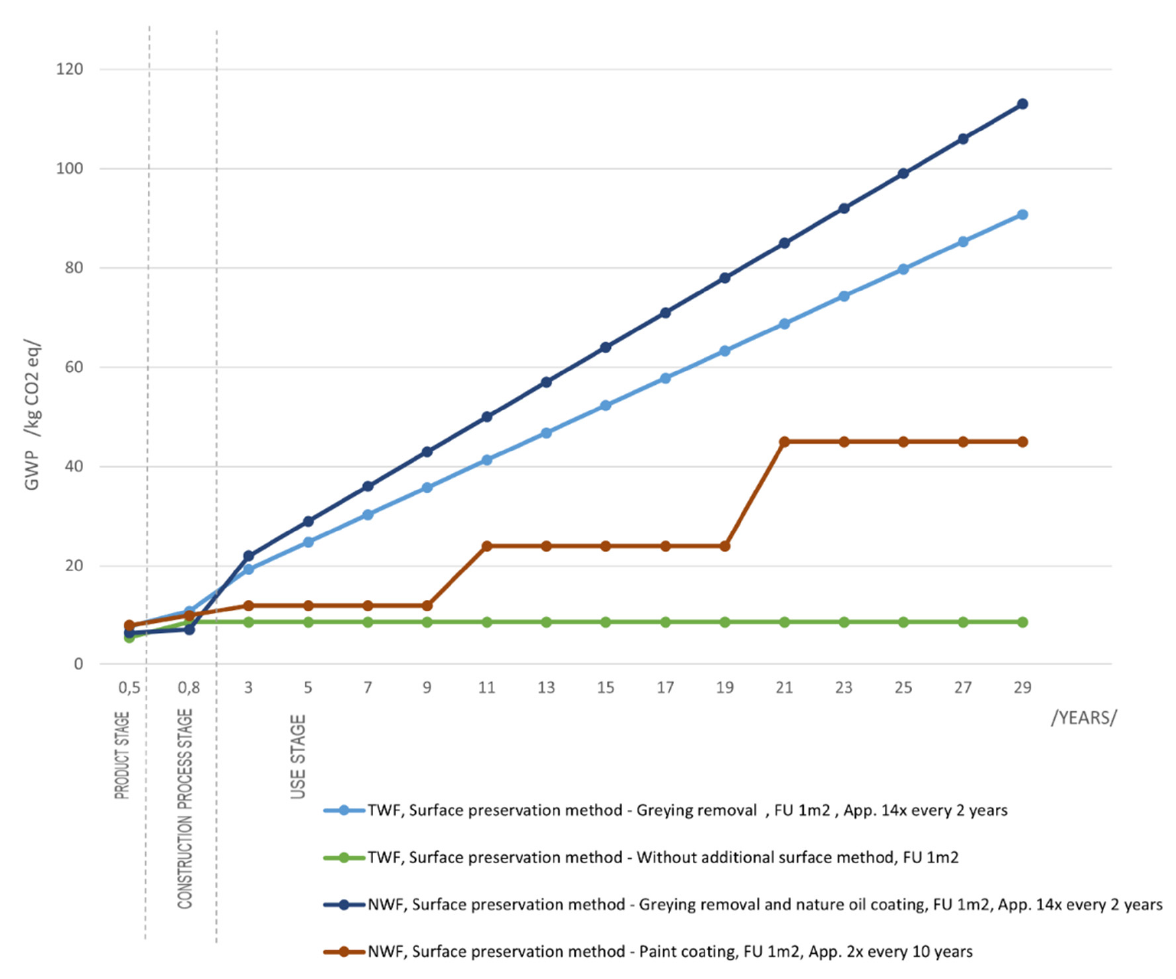
Figure 8. GWP parameter for a 30-year horizon determined by the EPD method, where maintenance-free service life of the thermally modified wood façade is declared by the manufacturer of (2018) V1. TWF—thermally modified wood façade, NWF—non-heat-treated wood façade.